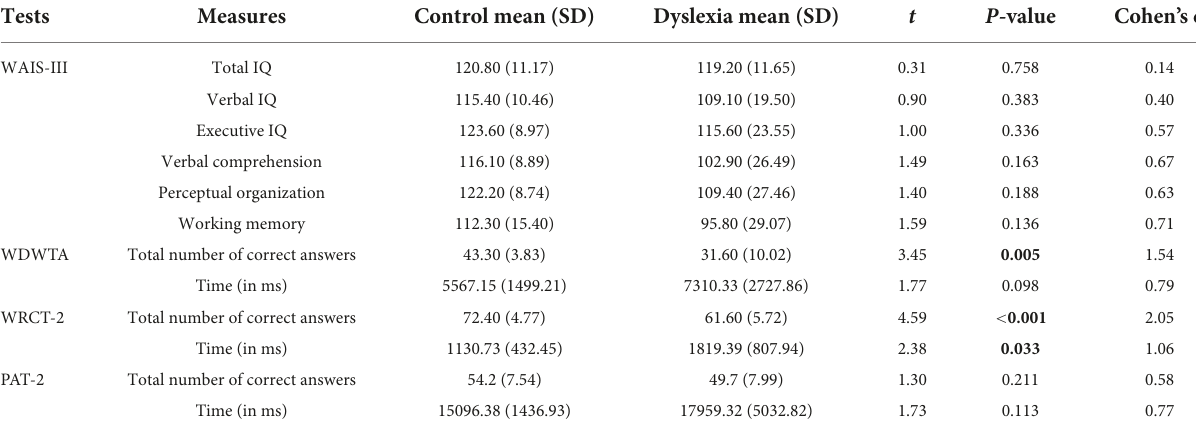
TABLE 1 Mean and standard deviation (SD) for the control and dyslexia group and their